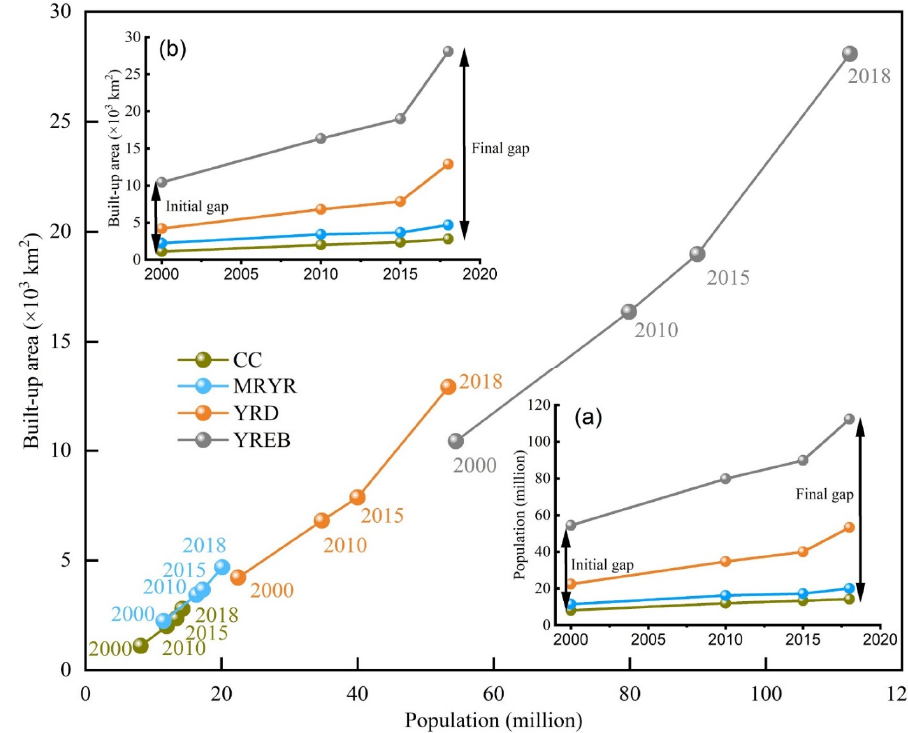
Figure 3. Relationship between population and built-up area at the UA level: ( a ) Trends of population growth across the four UAs (i.e., CC, MRYR, YRD, and YREB) from 2000 to 2018. ( b ) Trends of built-up expansion across the four major UAs from 2000 to 2018.